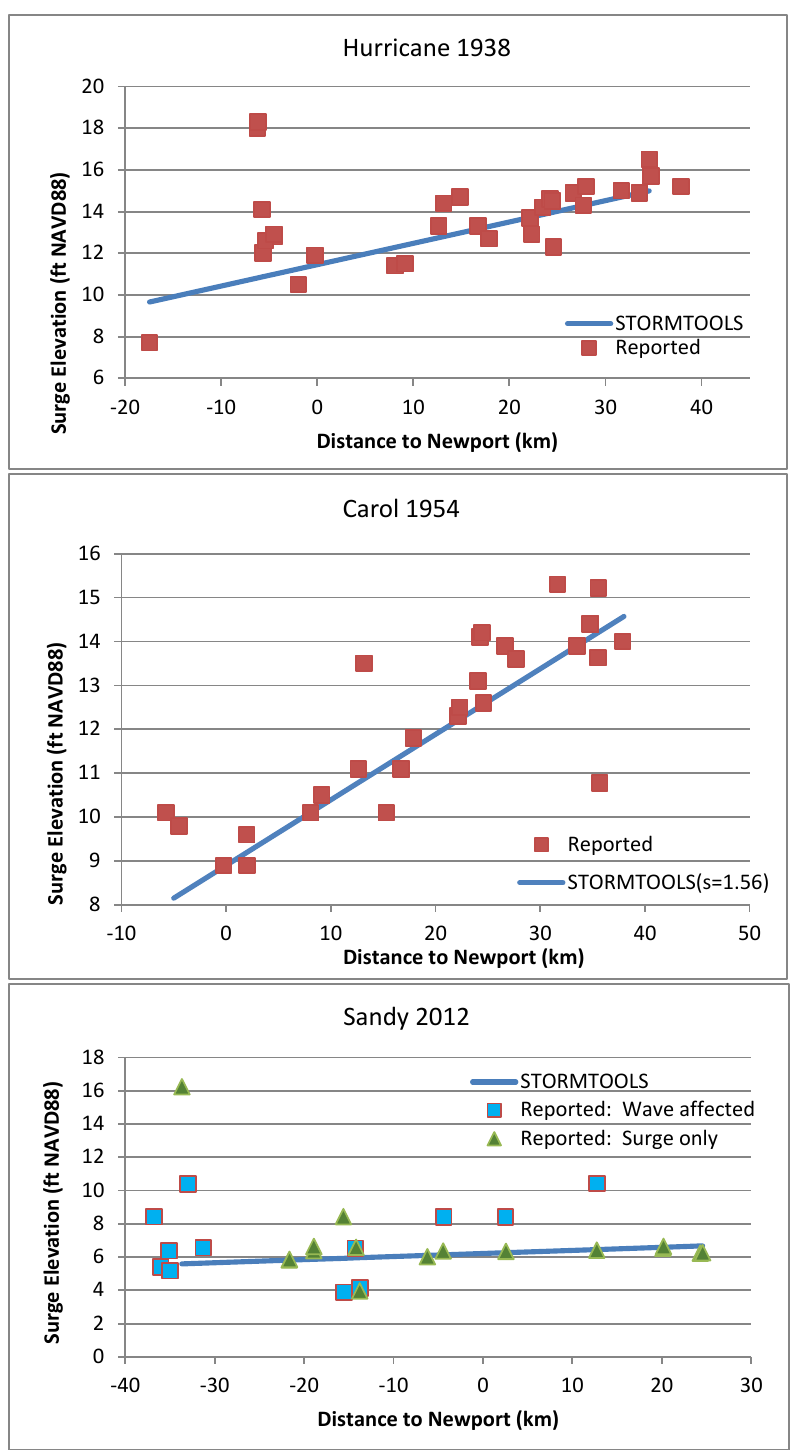
Figure A3. Peak storm surge water levels [2] for 1938, 1954, and 2012 hurricanes vs. distance up the bay referenced to Newport, RI. The data are fitted using a straight line with distance along the central axis of Narragansett Bay. Negative distances are to the west following the southern RI shoreline. (Figure 2, Spaulding et al. 2015 [9]). Data for 1938 and 1954 are based on observations collected during the event and provided in [2]. Data for 2012 were provided from temporary gauges deployed by US Geological Survey [27]. The slopes for the straight line fit to the data are 1.3 (1938), 1.56 (1954), and 1.1